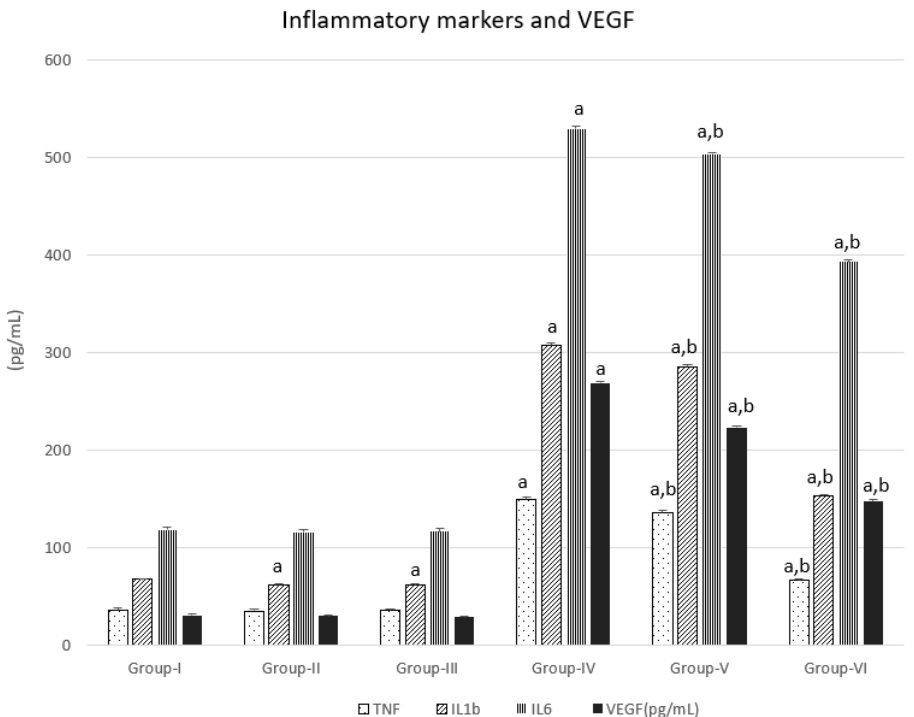
Figure 2. DMH, CUR, and CUR-loaded PLGA effect on serum inflammatory markers and VEGF in the animal groups. a represents statically significant differences at ( p < 0.05), compared different groups with Group-I and b represents statically significant differences at ( p < 0.05), compared different groups with Group-IV.